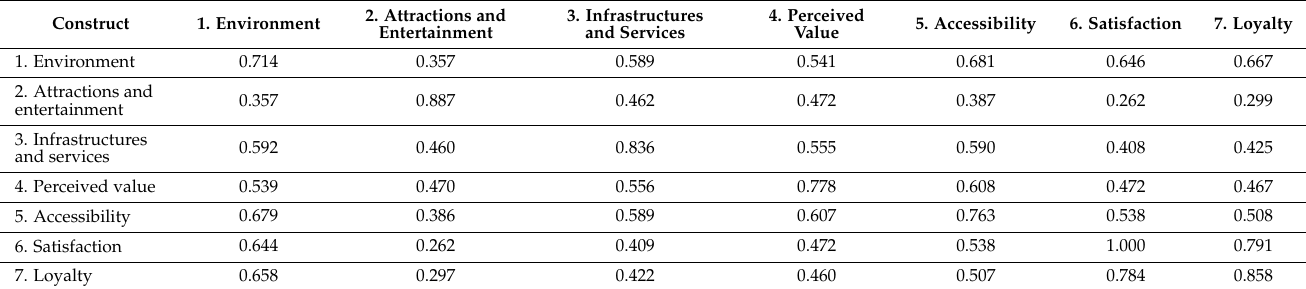
Table 4. Discriminant validity: Fornell and Lacker versus Heterotrait–Monotrait Ratio criteria.